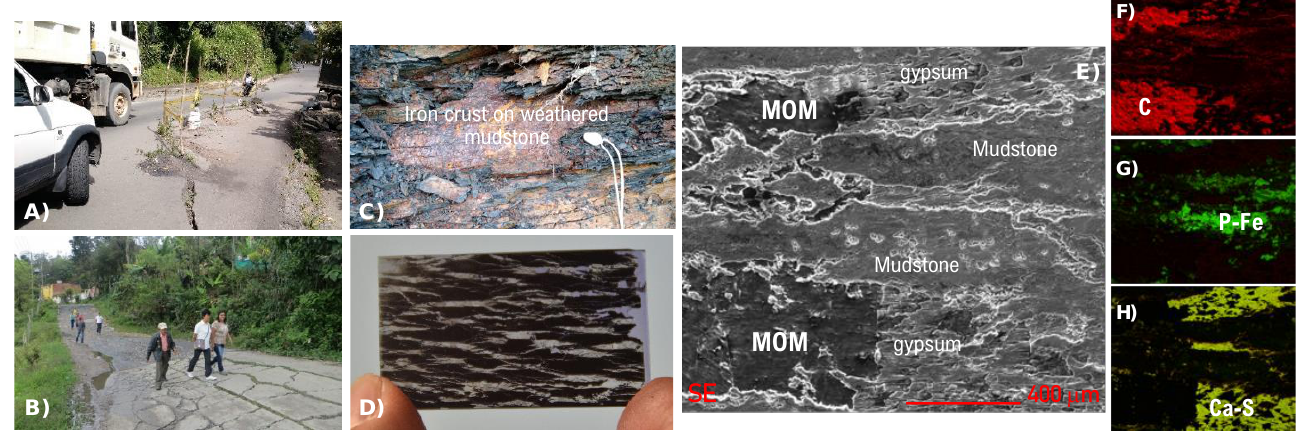
Figure 11. Subsidence in the national highway ( A ) and deformation in the old Calle Real ( B ) access to Vélez due to the presence of gypsum. Outcrop ( C ) where the stratigraphic column was lifted and samples were extracted for laboratory. Thin section (( D ): 4.5 × 2.7 cm 2 ) showing the fibrous and colorless gypsum in sheets, anastomosed within the gray mudstone. SEM-SE image ( E ) of the morphology of the components in thin section, subjected to EDS compositional mapping, in distinctive colors: ( F ) red, carbon (C) or organic matter corresponding to the dark sectors in the micrograph; ( G ) green, phosphorus (P) plus iron (Fe); ( H ) yellow for calcium (Ca) beside sulfur (S).